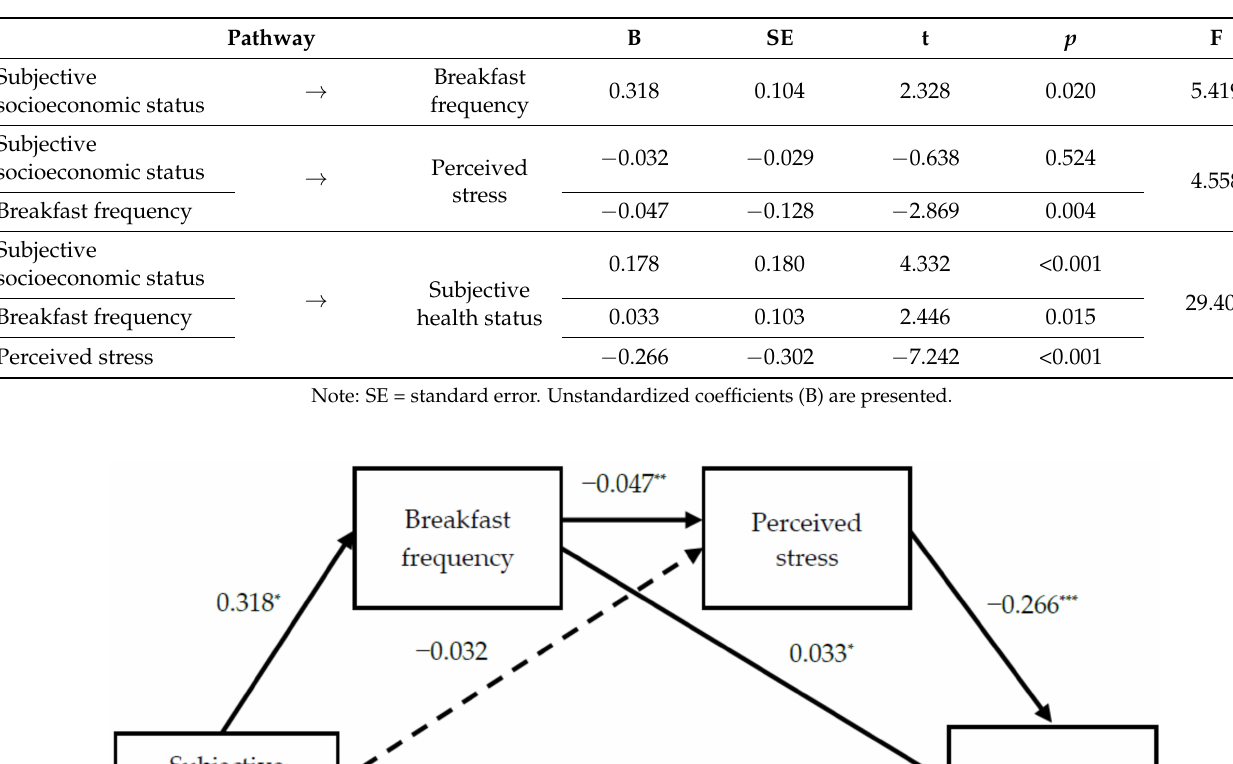
Table 3. Verification of the association between breakfast frequency and perceived stress in subjective socioeconomic status (SES) and subjective health status.